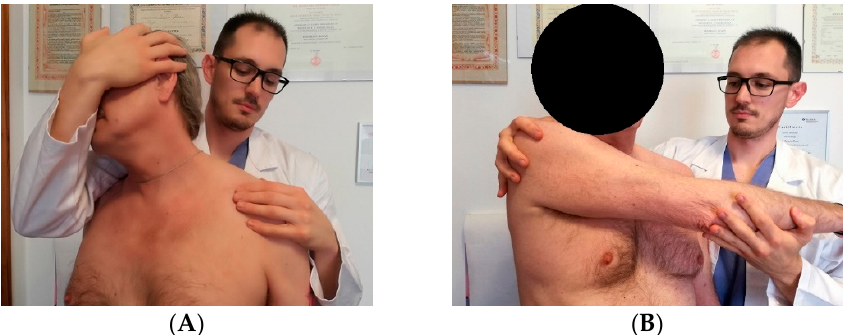
J. Clin. Med. 2020 , 9 , x FOR PEER REVIEW Figure 3. ( A ) Suprascapular stretch test; ( B ) Cross-arm adduction test. Figure 3. ( A ) Suprascapular stretch test; ( B ) Cross-arm adduction test. Figure 3. ( A ) Suprascapular stretch test; ( B ) Cross-arm adduction test.